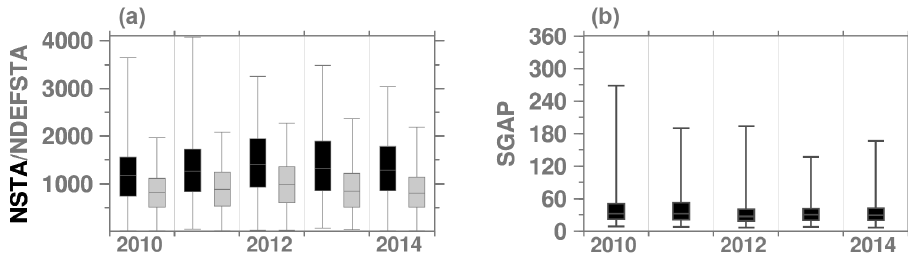
Figure 20. Box-and-whisker plots of (a) the number of stations (NSTA, black) and defining stations (NDEFSTA, grey) and (b) of the secondary azimuthal gap (SGAP) in each year for the earthquakes added for the period 2010–2014.